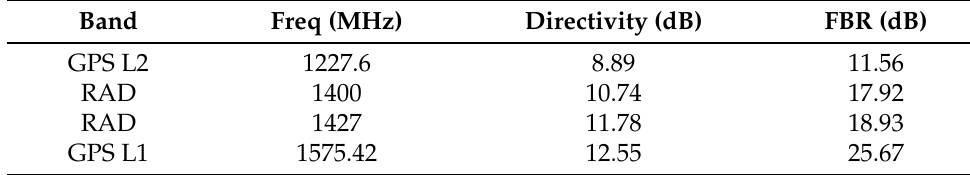
Table 11. Cubic cup ground plane measurements.